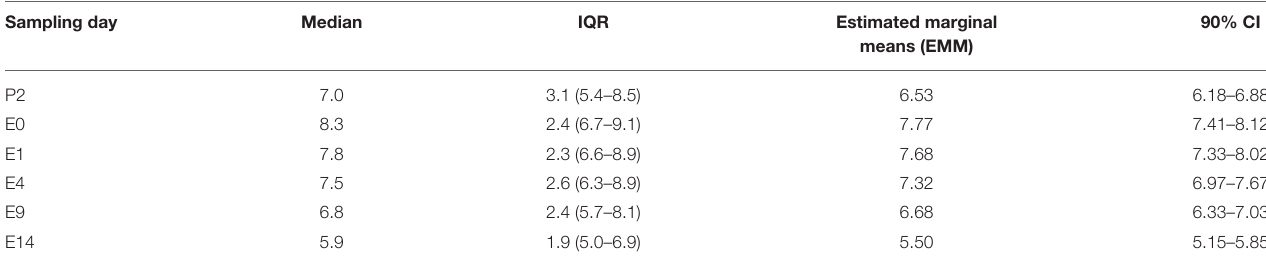
TABLE 4 | Distribution and summary values of log 10 Bifidobacterium copy number/gram fecal for 121 calves as determined by qPCR, stratified by sampling day (P2 = day 2 of age, E0 = day prior to enrollment, E1 = enrollment day and 1st follow-up day, E4 = 4th follow-up day, E9 = 9th follow-up day, and E14 = 14th follow-up day. Sampling